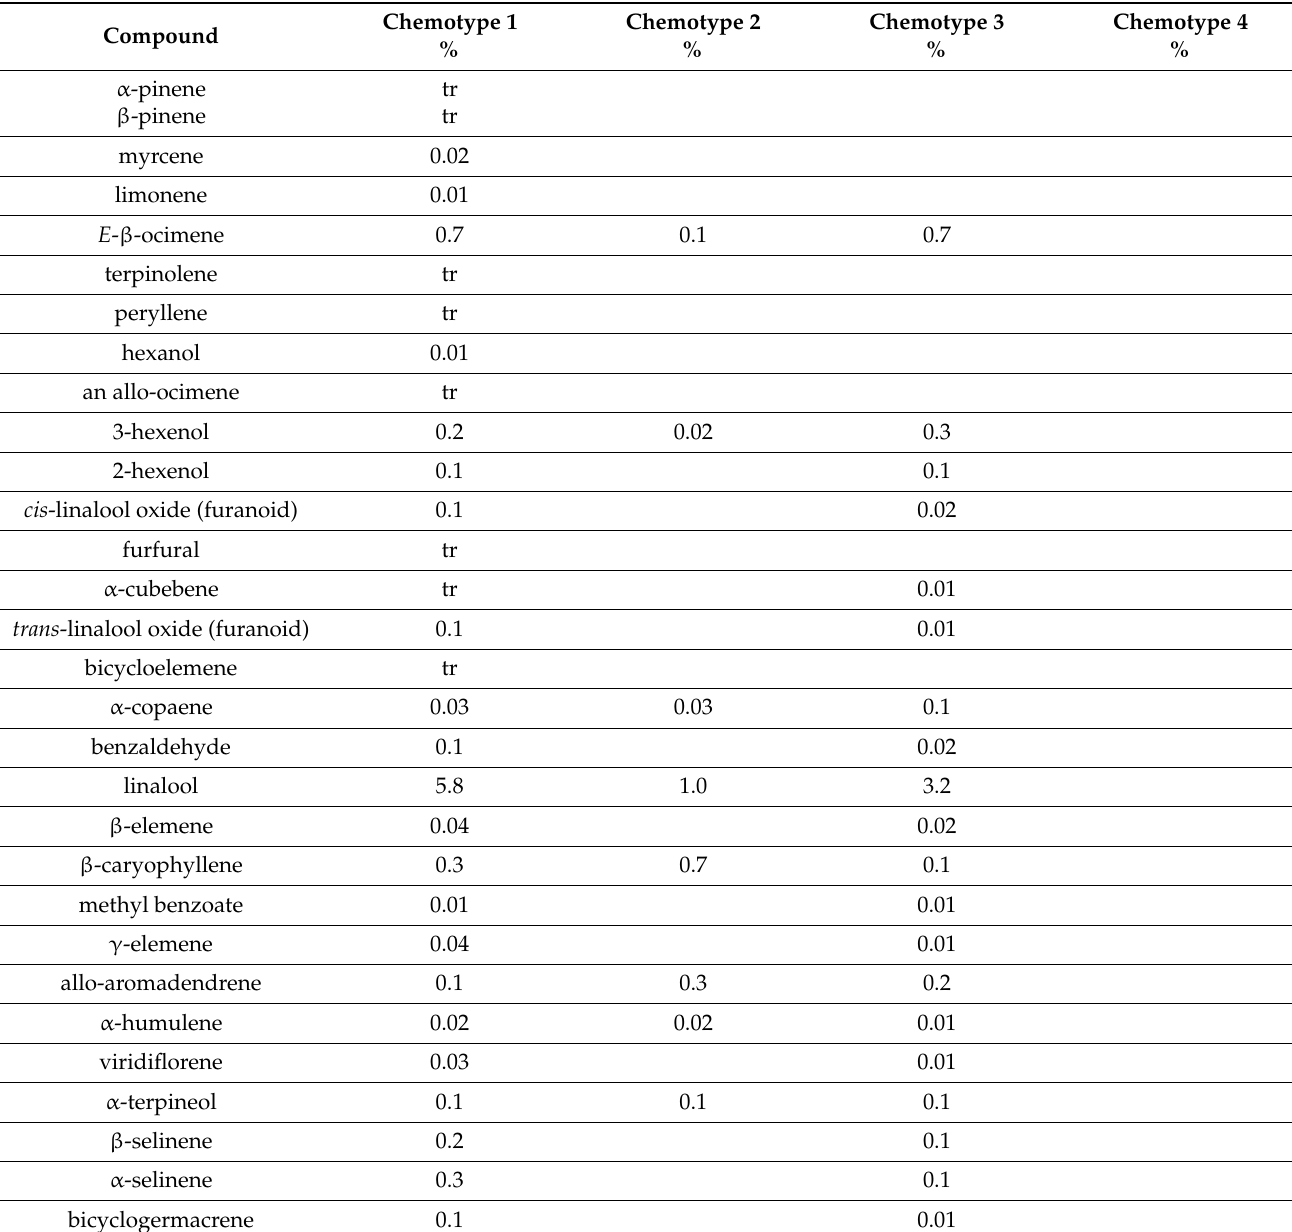
Table 10. Compounds identified in the four chemotypes of Backhousia myrtifolia